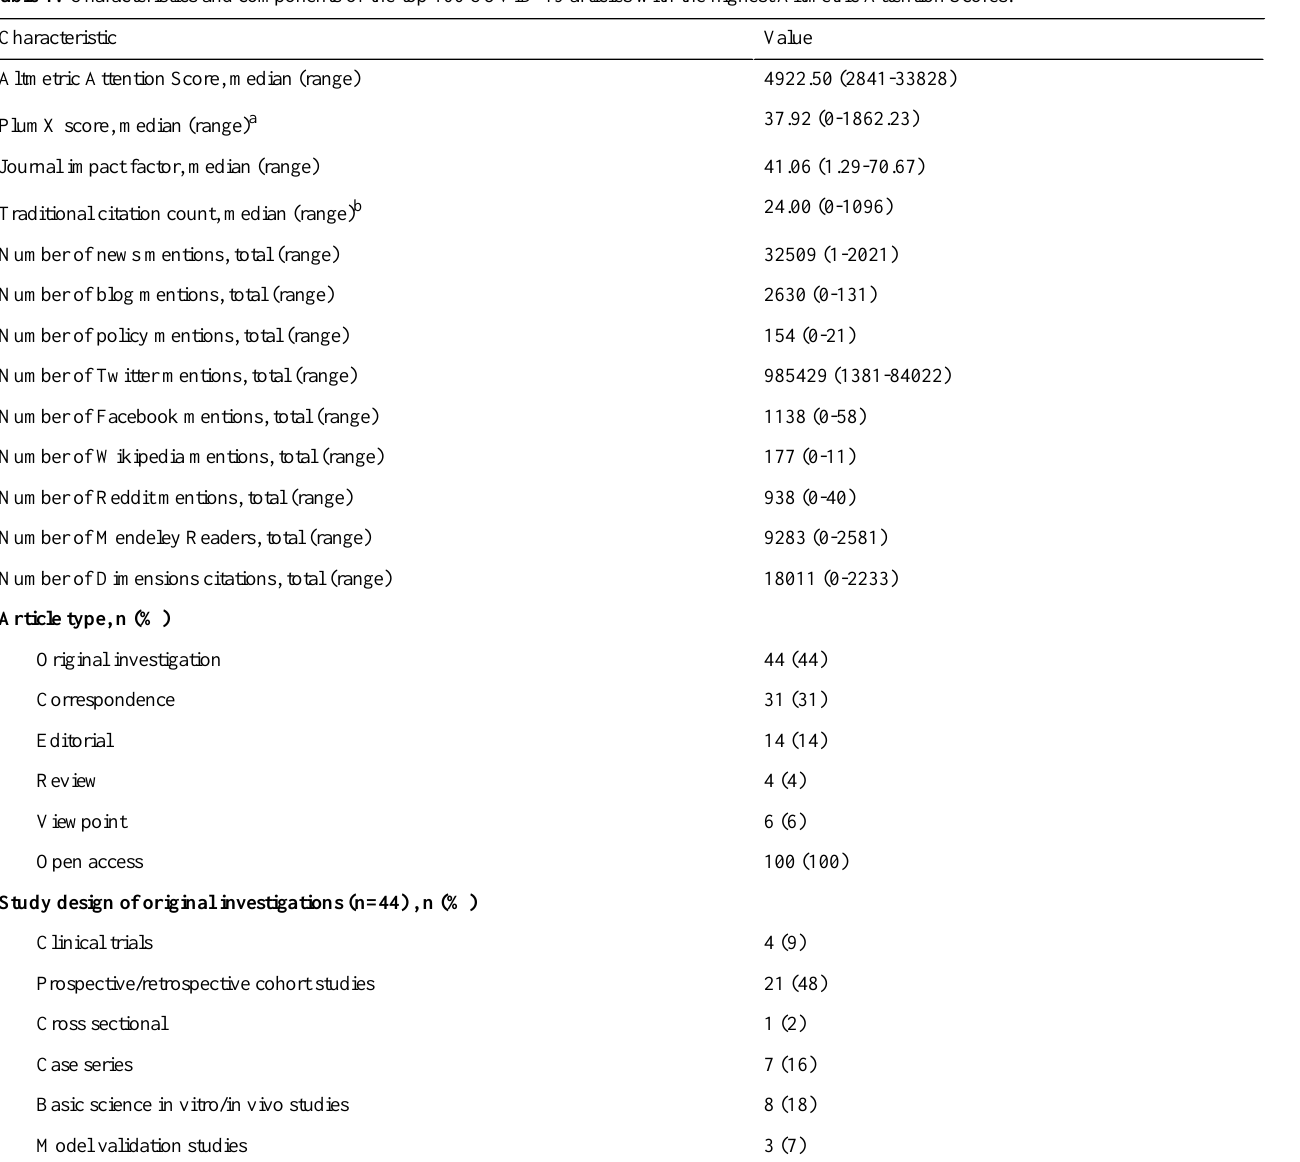
Table 1. Characteristics and components of the top 100 COVID-19 articles with the highest Altmetric Attention Scores.